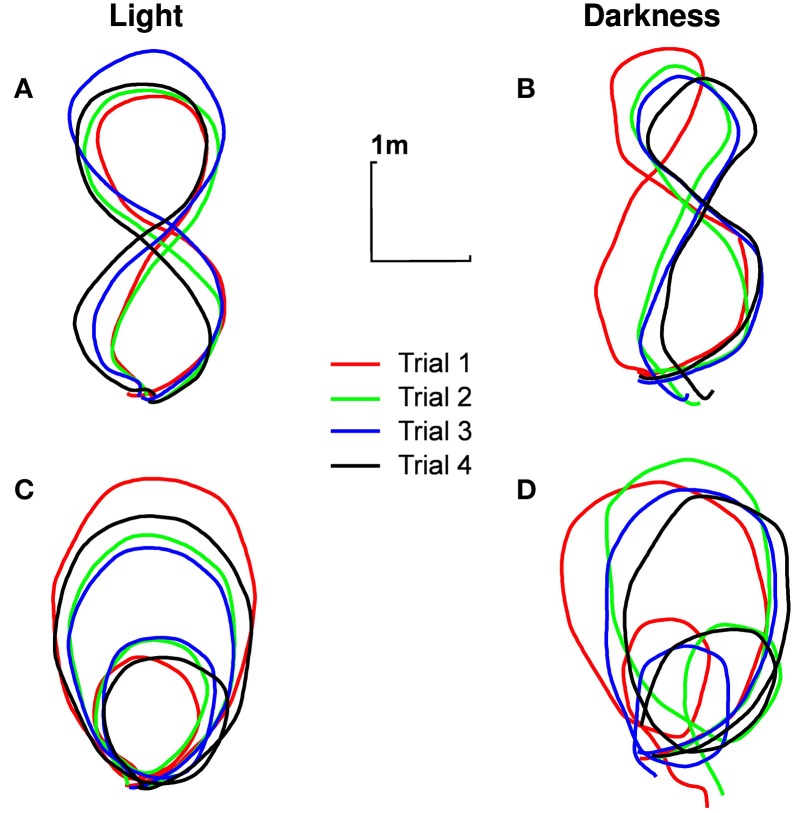
Typical trajectories followed by participants. Trajectory of the pelvis of participant n°1 in the ground plane, for different experimental conditions [(A) eight shape in light, (B) eight shape in darkness, (C) limaçon in light, (D) limaçon in darkness]. The four trials are presented (in order of realization: red, green, blue, black).